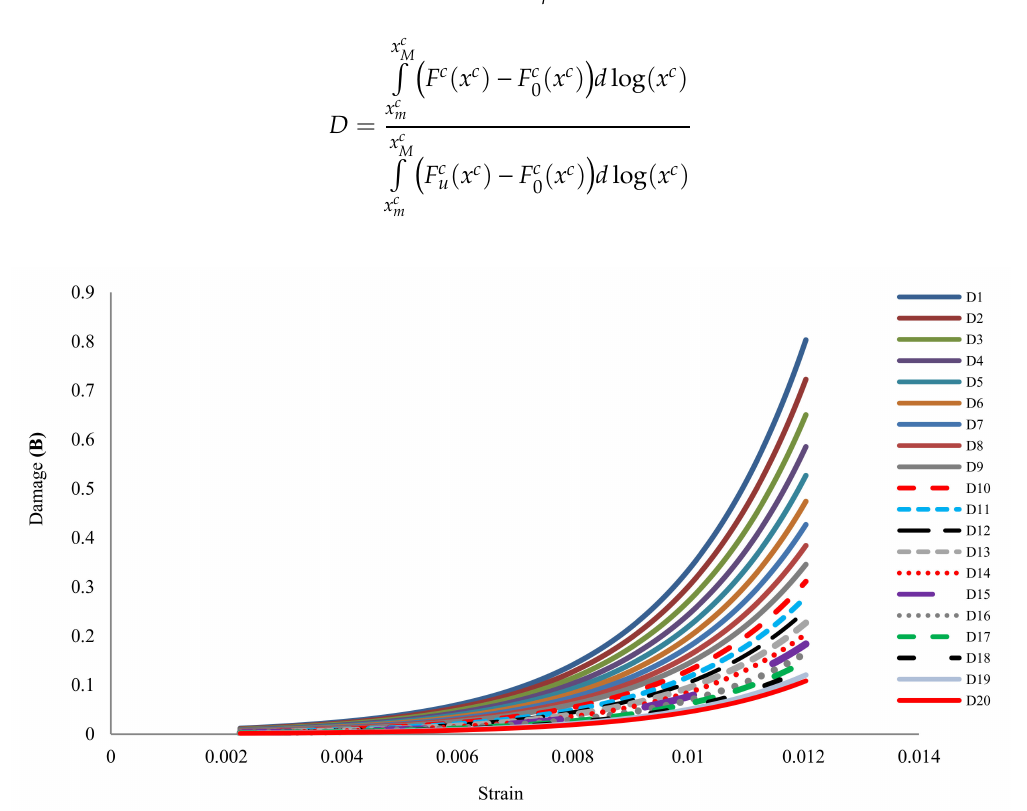
Figure 1. The suggested damage range in coal mass ( B